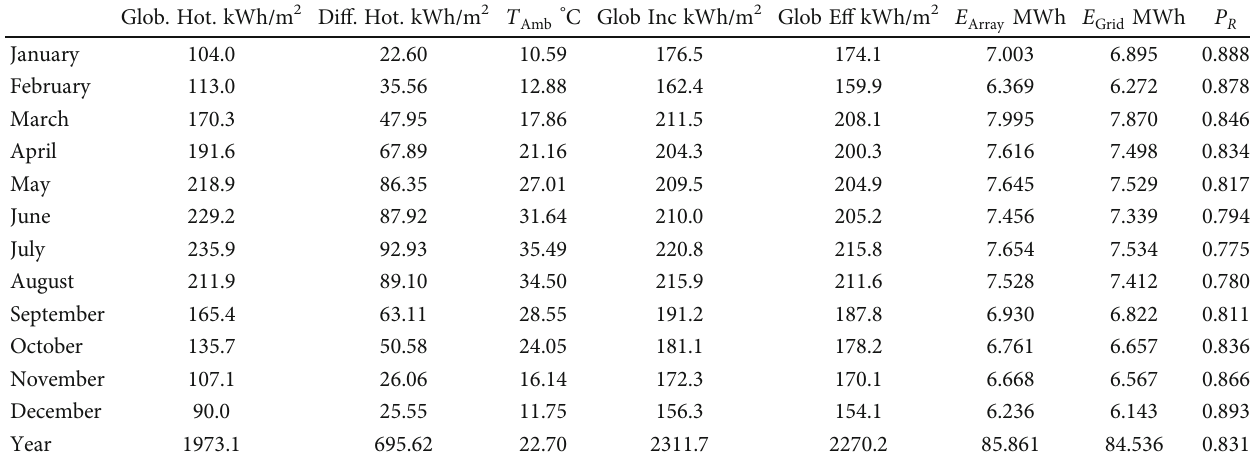
Figure 2: Design of the grid-connected PV system. Table 2: Fundamental results of the PV system